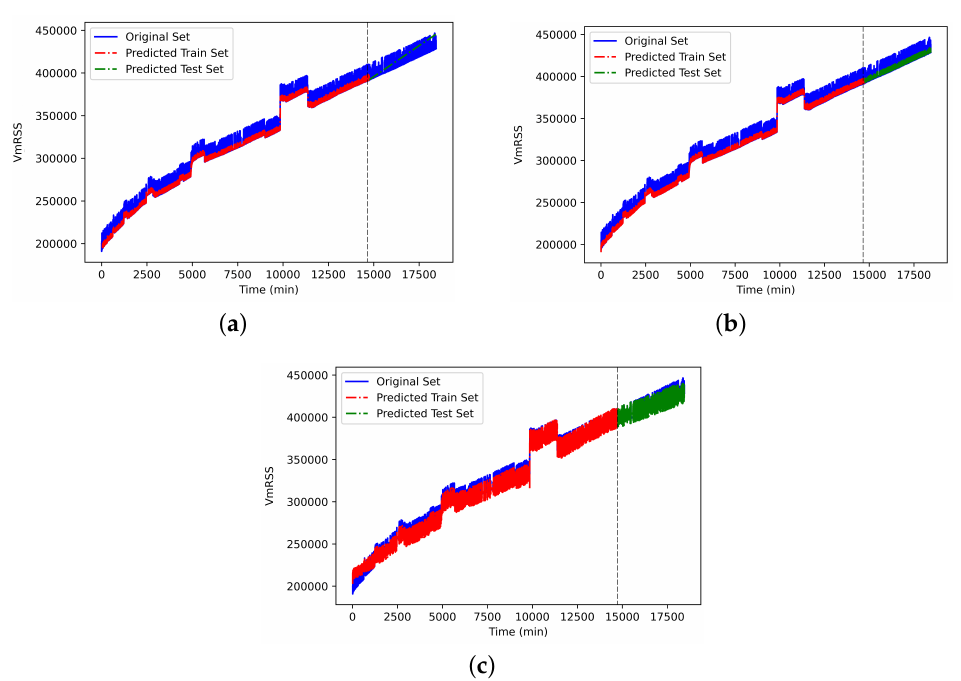
Figure 8. Graphics for data type “memory used with five VM”: ( a ) ARIMA; ( b ) Vanilla-LSTM; ( c ) proposed (moving average +